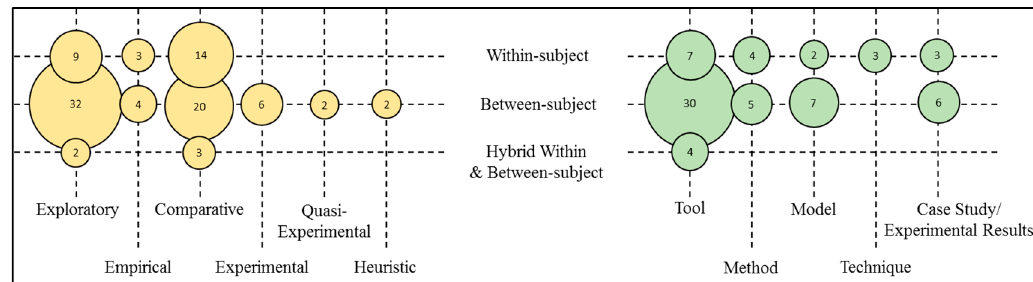
Figure 17. Two-dimensional mapping of research types with evaluation types and contribution types with evaluation types.